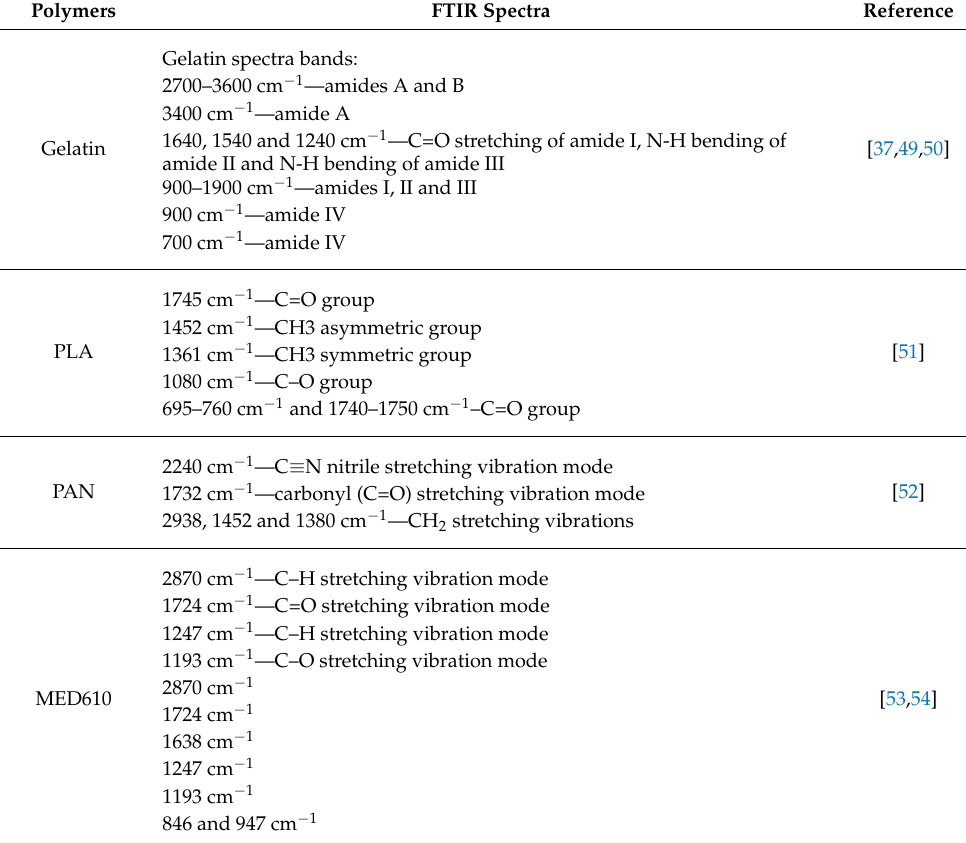
Table 3. Overview of the typical FTIR spectra of gelatin, PLA, PAN and